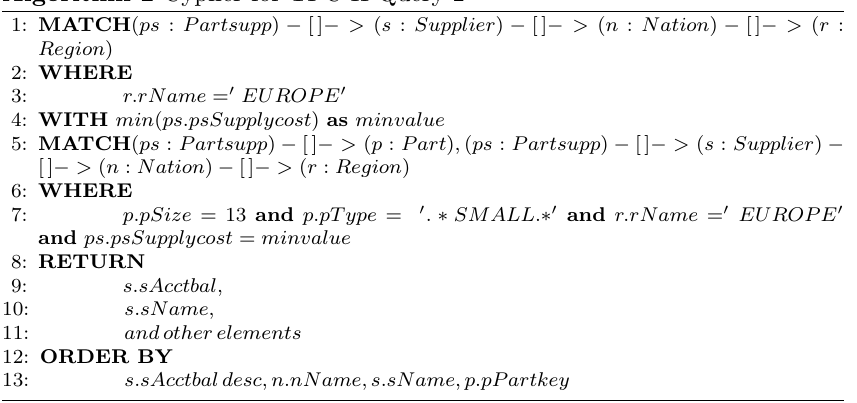
Algorithm 2 Cypher for TPC-H Query